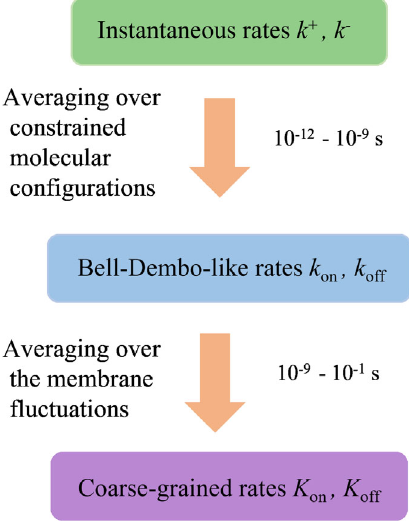
FIG. 2. Schematic representation of the rate averaging pro- cedure and the relevant timescales in the